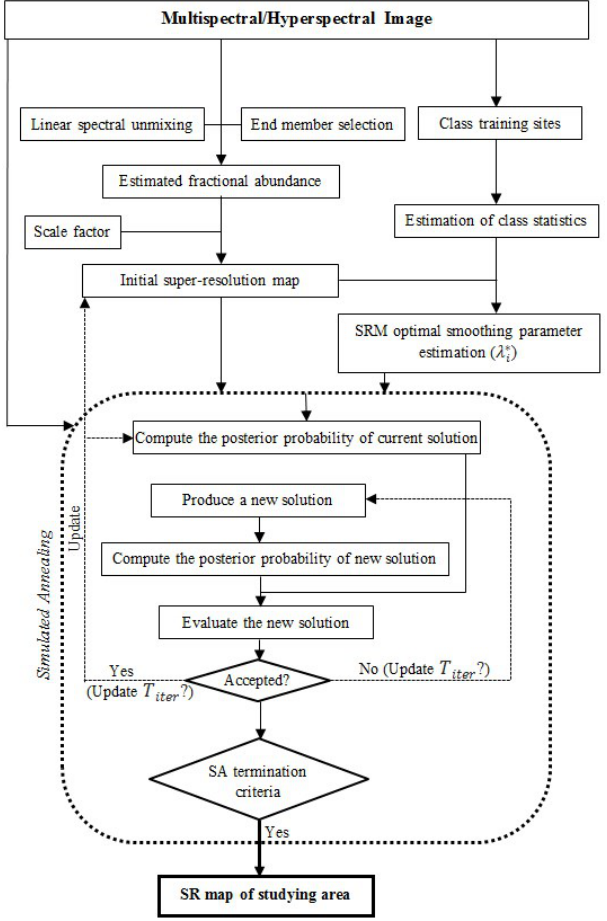
Figure 1: Workflow of adaptive super-resolution